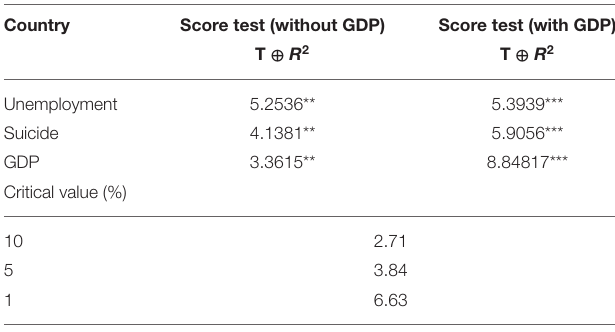
TABLE 3 | Score tests for non-linearity.